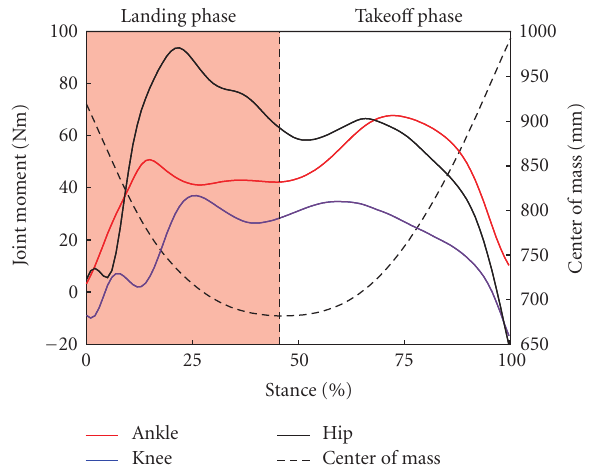
Figure 1: Lower extremity joint moments from one subject illustrating identification of landing and takeo ff phases during the drop vertical jump maneuver. Phases were divided based on the lowest point of the body’s center of mass. Maximum extensor moments were determined for the ankle, knee and hip during each phase.